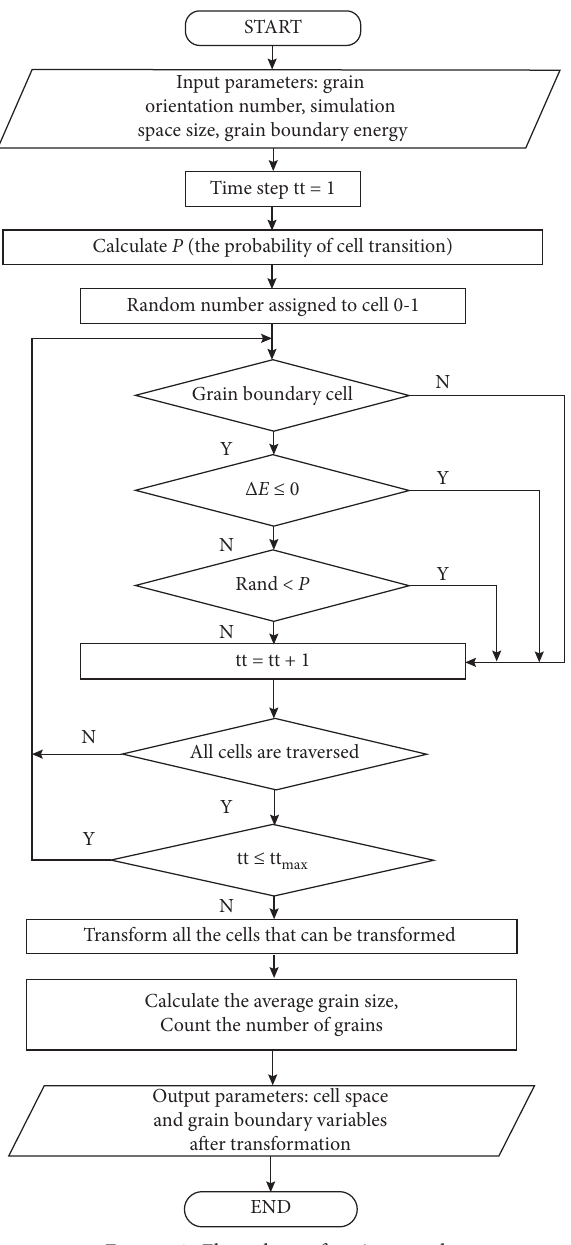
Figure 2: Flow chart of grain growth.